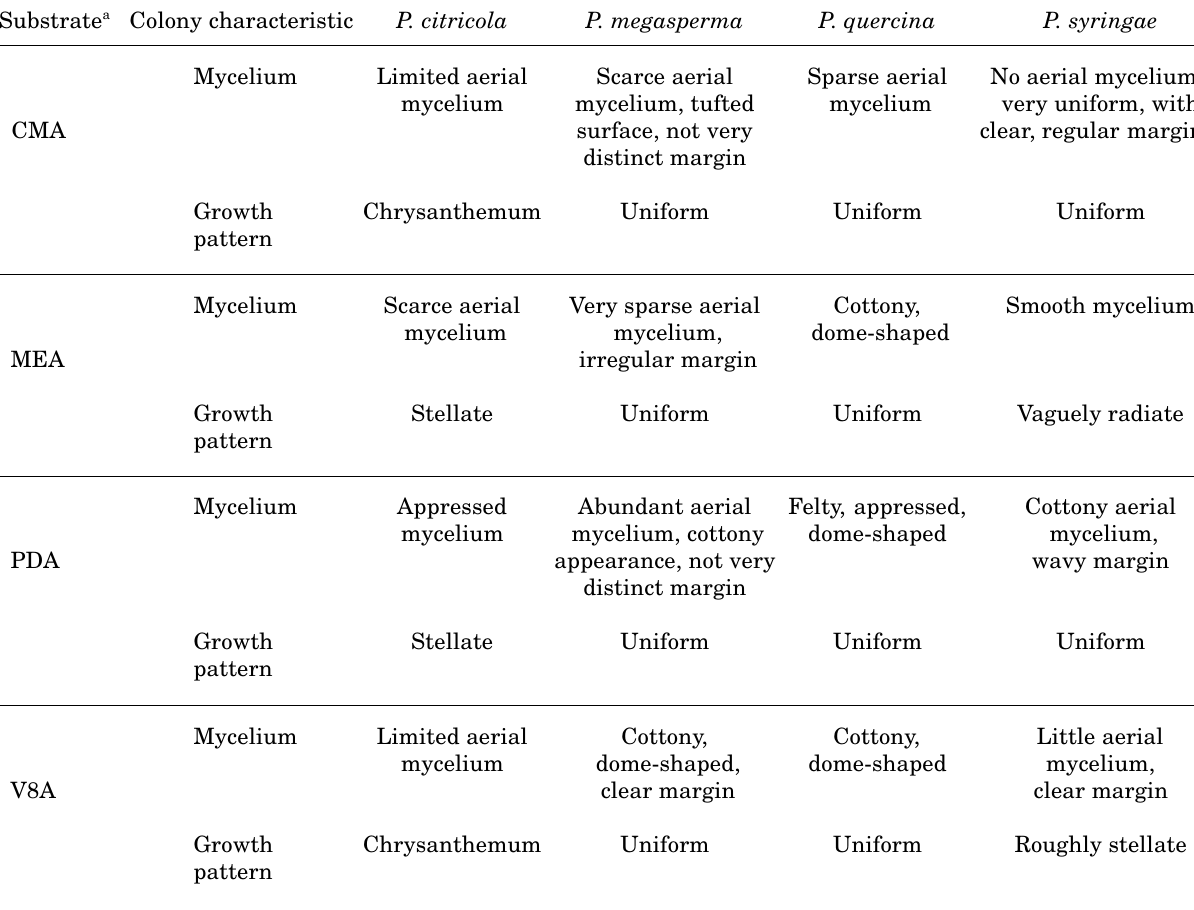
Table 3. Colony morphology on four different substrates of four Phytophthora species collected from Quercus cerris and Quercus robur forests soils in northern and central Italy.